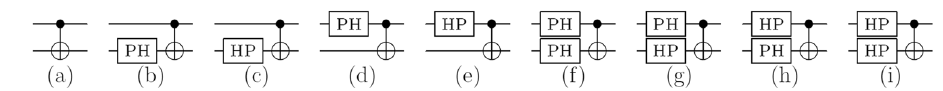
Fig. 3 CNOT gate equivalent entangling transformations that need to be applied to each of n ð n (cid:2) 1 Þ element implementable with k entangling gates to explore the possibility of expanding it into a Clifford group element requiring k + 1 gates. It suf fi ces to apply these gates to a pair of qubits in an arbitrary fi xed order, since the application of a gate in the other order is enabled by some other gate among those listed. For instance, the CNOT with fl ipped controls with respect to ( a ) is accomplished by ( h ), noting that the single-qubit gates on the right side do not matter due to the choice to work with equivalence